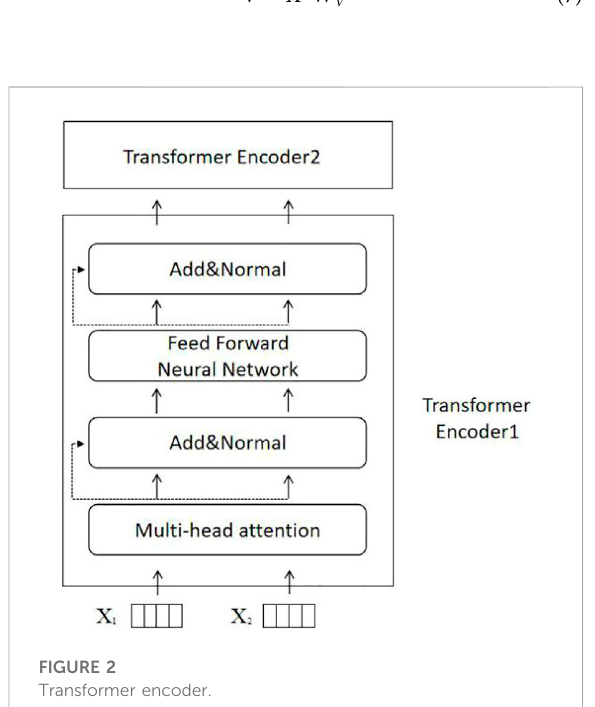
FIGURE 2 Transformer